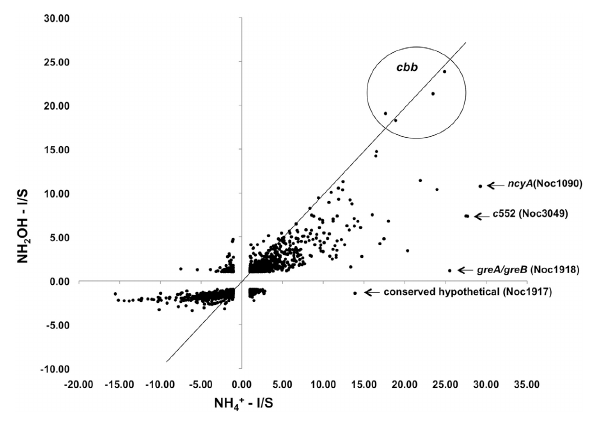
FIGURE 2 | Expression ratios for genes across the N. oceani genome (chromosome and plasmid) for hydroxylamine-induced versus ammonium-induced cells relative to a starved-cell control.